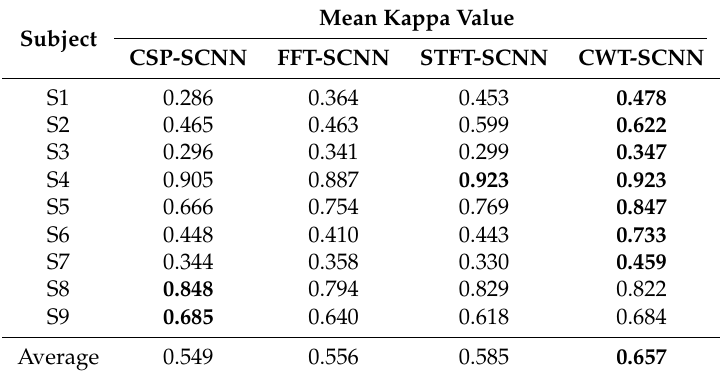
Table 5. The mean kappa value results of the CWT-SCNN, CSP-SCNN, FFT-SCNN, and STFT-SCNN